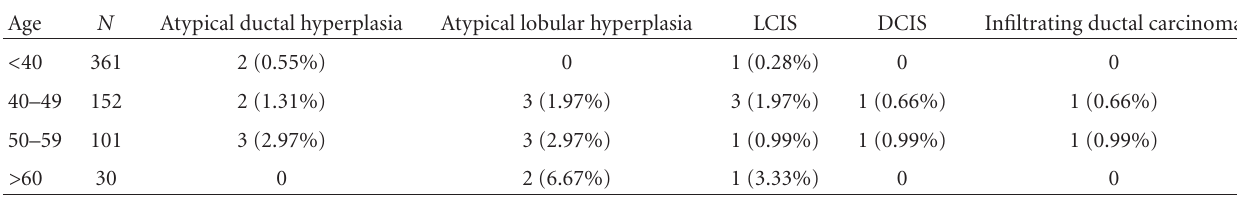
Table 1: Bilateral reduction mammaplasty.